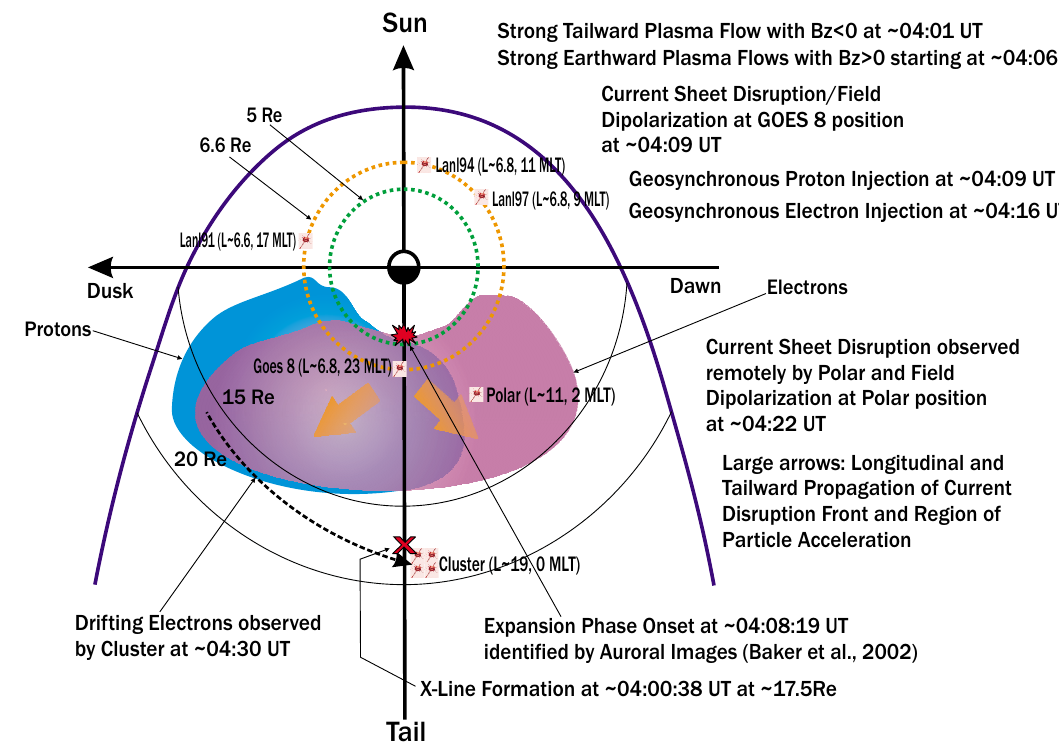
Fig. 13. Qualitative illustration of the scenario on how we envisage the whole process to evolve during the substorm event. We assume that the region affected by the disruption of the cross-tail current expands, both in local time and radius, as the region of instability expands, similar to the way an interface between elastic, crashing bodies propagates backwards with no constant velocity. At the time of expansion phase onset, in a spatially limited region of the cross-tail current sheet near the Earth (which we infer to be inside geosynchronous orbit), the dynamical change in B z alters the relative drift velocity between ions and electrons, thus triggering in this way an instability (KCSI/CFCI). The excited waves and the associated wave-particle interactions cause particle pitch angle scattering which fills the loss cones diverting the cross-tail current into the ionosphere, thus forming the current wedge. Within the region affected by the disruption, particles are locally energized as the disruption front passes over them. This mechanism is responsible for the energization of the electrons, which are subsequently transported by means of gradient/curvature drift to the Cluster